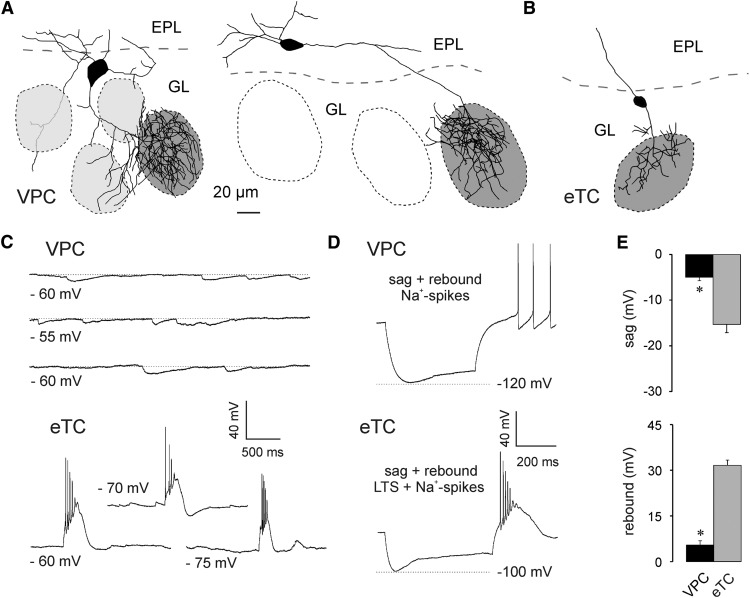
A, Two representative VPC reconstructions. The dark gray shading indicates the glomerulus innervated by the dendritic tuft of the respective VPC. VPCs bear several lateral dendrites that either run below the GL or lie above or underneath other glomeruli (light gray shading). B, Representative reconstruction of an eTC. C, Representative spontaneaous IPSPs and bursts of 3 different VPCs and eTCs, respectively. D, Representative responses to somatically applied current steps (−90 to −100 pA; 800 ms) to VPCs and eTCs. E, Cummulative comparison of the sag (top) and the rebound depolarization/LTS (bottom) of VPCs (N = 23) and eTCs (N = 17). * p < 0.001 versus eTC. T-test for independent variables. Data are mean ± SEM.